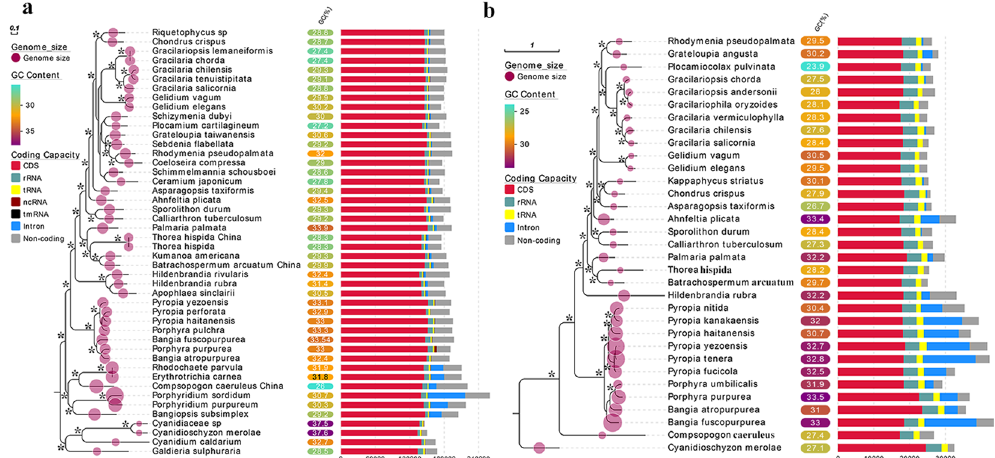
Figure 4. Bayesian phylogenetic trees based on organelle genomes, with each genomic features labeled on the tree. ( a ) Bayesian phylogenetic tree based on chloroplast genome. ( b ) Bayesian phylogenetic tree based on mitochondrial genome. Note: Asterisks on the nodes represent supporting values of Bayesian inference for 100% and Maximum Likelihood bootstrap more than